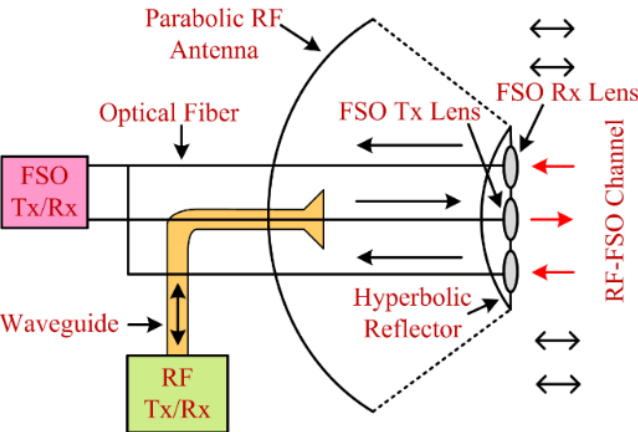
Figure 21. Design of an integrated RF–FSO antenna.